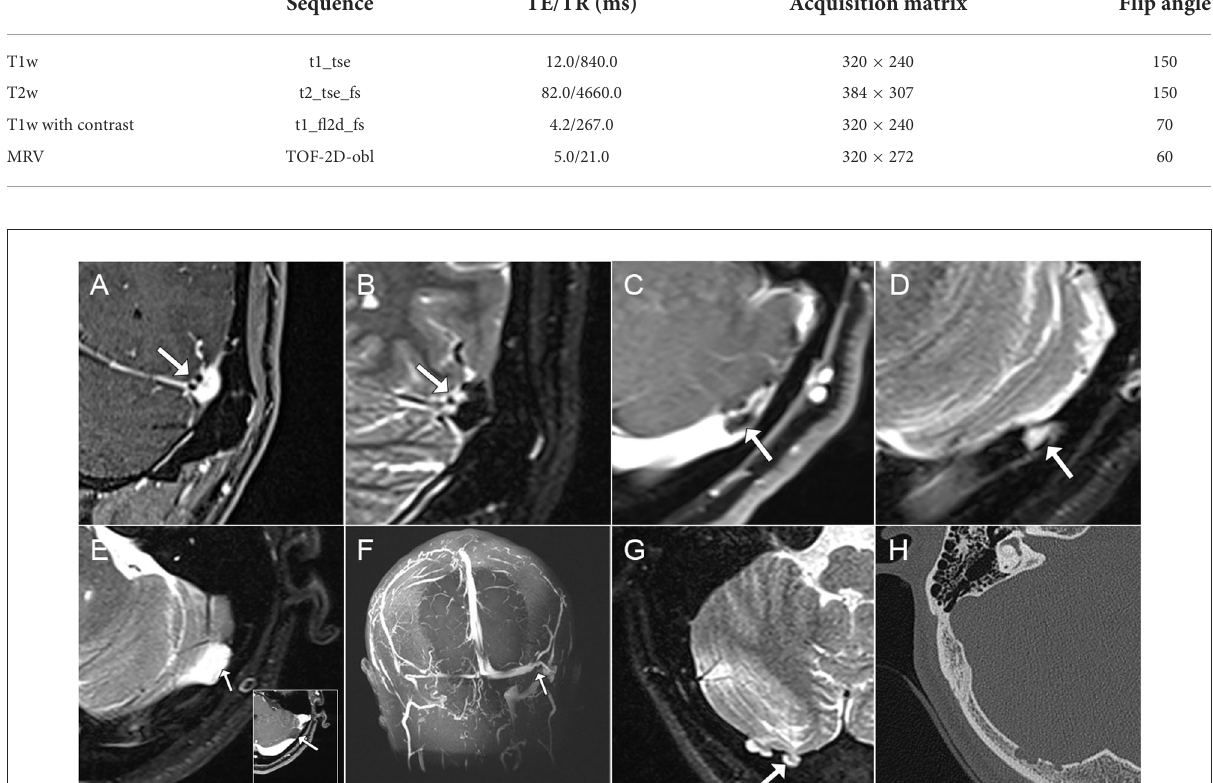
FIGURE2 Characteristics of transverse sinus (TS) endoluminal invagination of arachnoid granulation (AG), arachnoid cyst, and brain herniation into AG. (A,B) Coronal contrast-enhanced T1-weighted and T2-weighted magnetic resonance (MR) images showcasing endoluminal invagination of AG inside TS. (C,D) Axial contrast-enhanced T1- and T2-weighted MR images showcasing obstruction of TS lumen by an AG. (E,F) Axial T2-weighted/contrast-enhanced T1-weighted and Coronal maximum intensity projection MR venogram images demonstrating the intrinsic compression of TS lumen from an arachnoid cyst causing TS stenosis. (G,H) Brain herniation in AG perforating the occipital bone structure using axial T2-weighted MR and CT